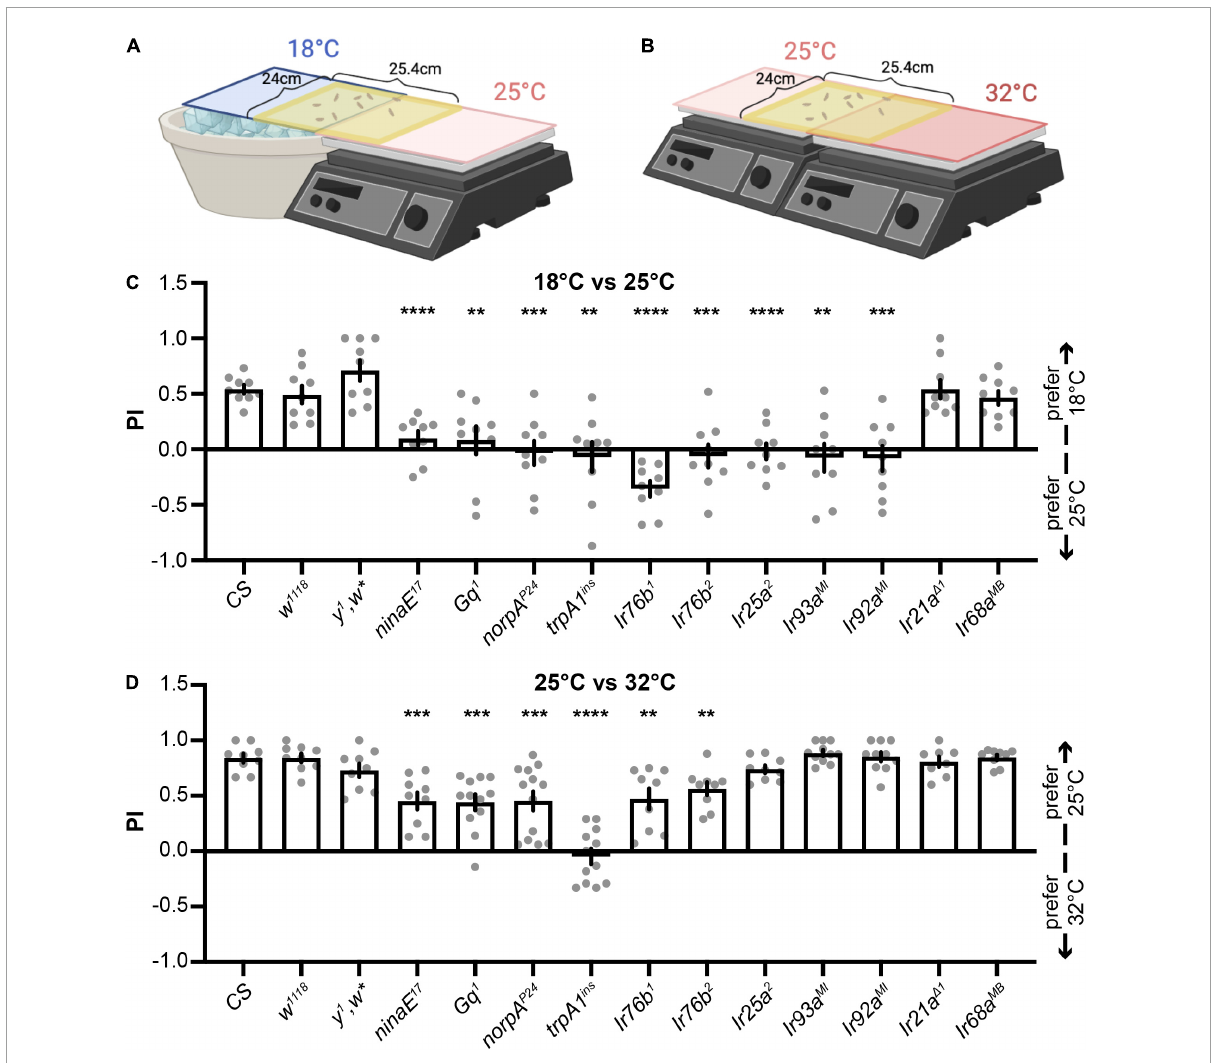
FIGURE1 The Rh1 pathway and IRs expressed in DOGs regulate different thermotactic behaviors. (A,B) Schematics of two-choice assays (created with BioRender). Early third-instar larvae were released in the middle of a testing gel and allowed to choose between 18 ◦ C and 25 ◦ C (A) or between 25 ◦ C and 32 ◦ C (B) for 2 min. The number of larvae in each temperature zone was counted and used to calculate the preference index (PI) to cool temperatures. (C,D) PIs of indicated genotypes obtained from larval thermotactic assays between 18 ◦ C and 25 ◦ C (C) or between 25 ◦ C and 32 ◦ C (D) . n = 8–13; data represent means ± s.e.m; ** P < 0.01, *** P < 0.001, and **** P < 0.0001, comparing PI with the corresponding CS , the Welch’s test, except the Mann–Whitney test for the comparison of CS and Ir21a (cid:49) 1 in (C) , CS and norpA P 24 in (D) , and CS and Ir68a MB in (D) .